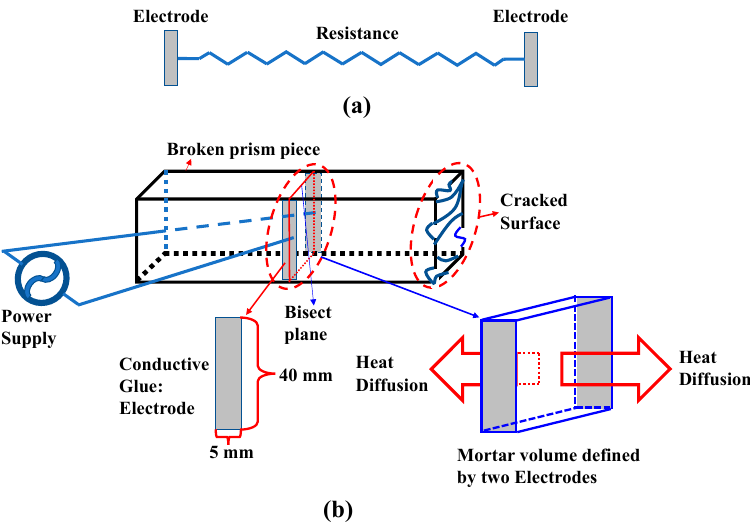
Figure 3. Equivalent circuit of the mortar prisms. ( a ) Equivalent circuit of the prisms. ( b ) A schematic of electrical connection.